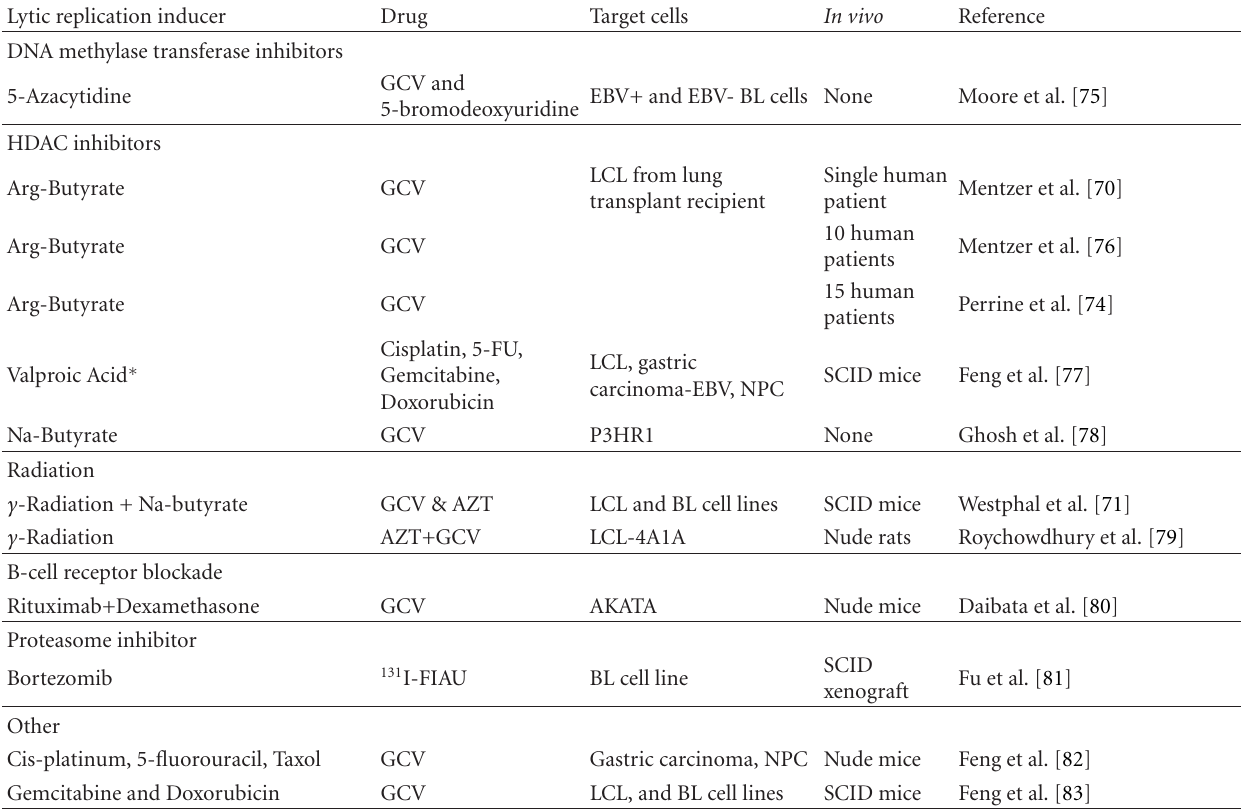
Table 3: Combination therapy approaches in the treatment of EBV